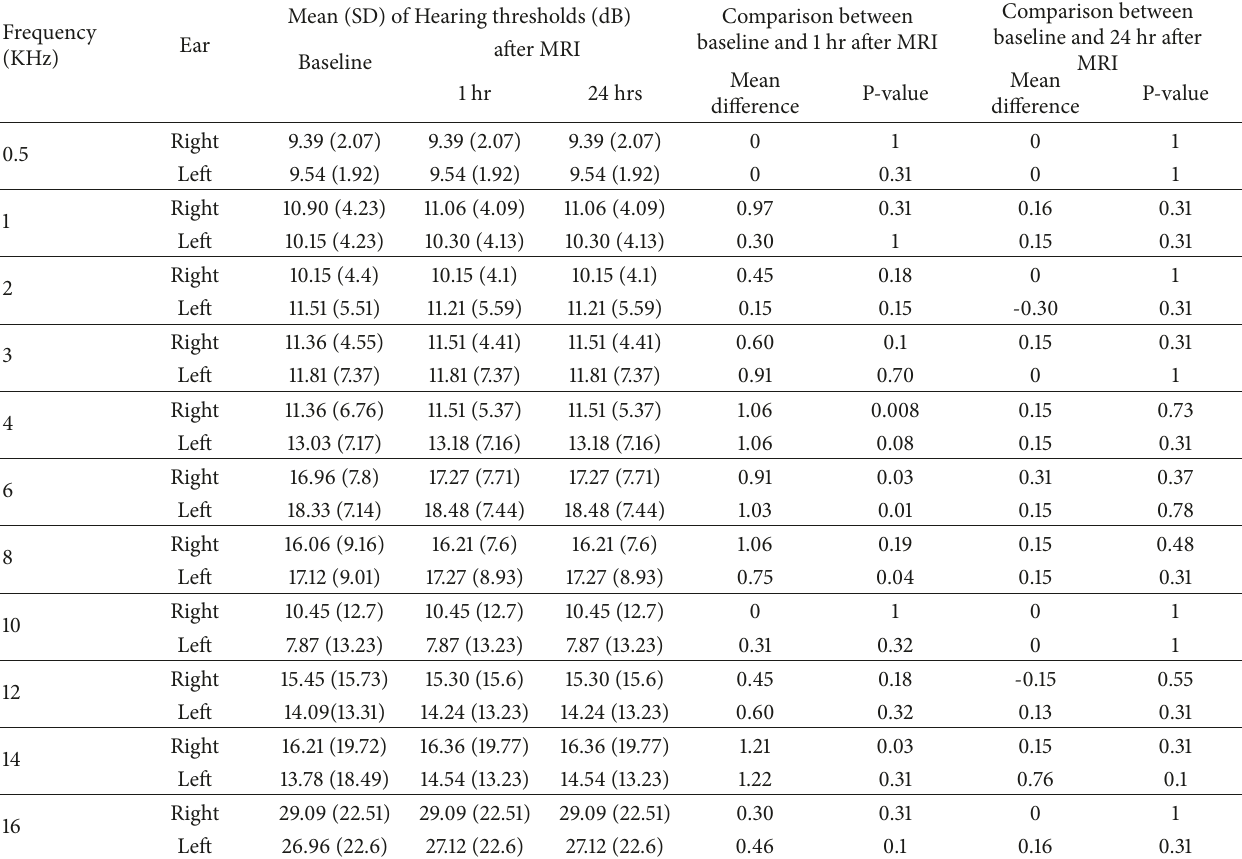
Table 1: Comparison of mean of hearing thresholds at different frequencies of both ears before MRI (baseline), 1 hour after MRI (TTS), and 24 hours after MRI (PTS).